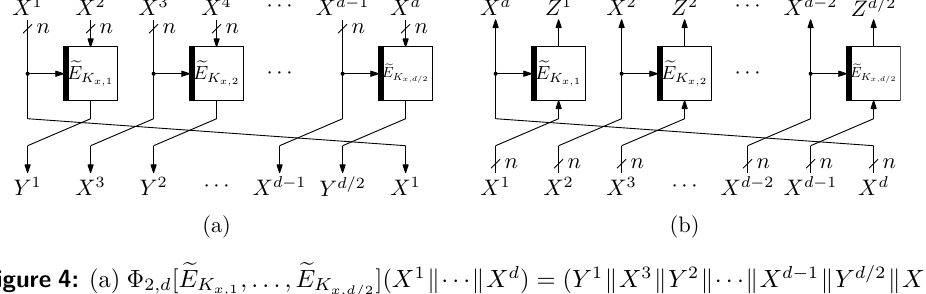
Figure 4: (a) Φ 2 ,d [ e E K